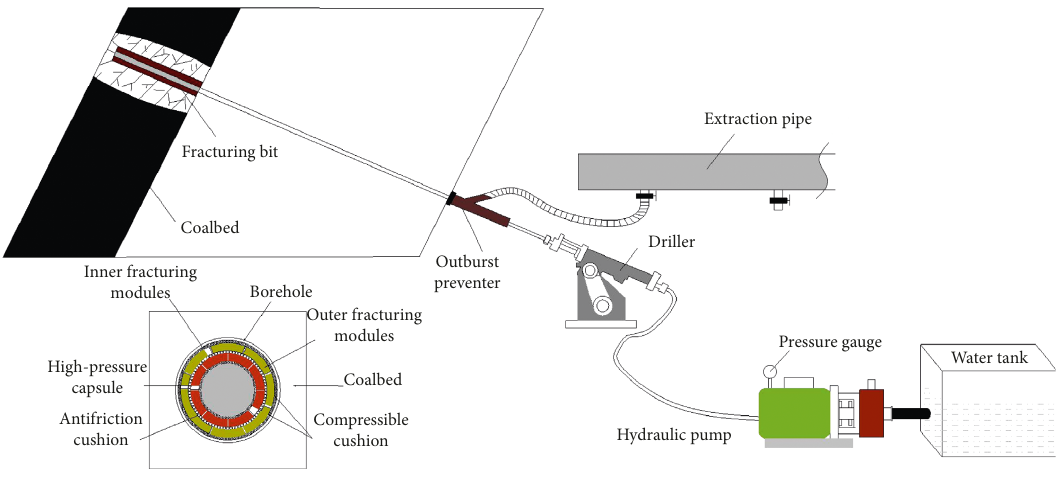
Figure 2: Operation chart of static fracturing technology.